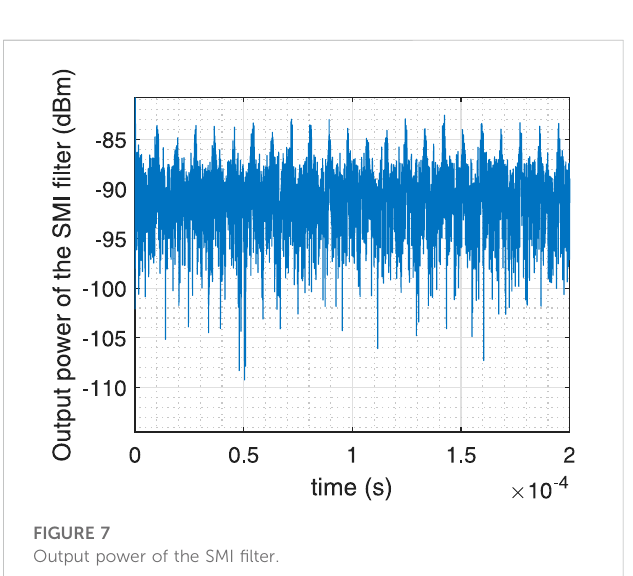
FIGURE 7 Output power of the SMI fi